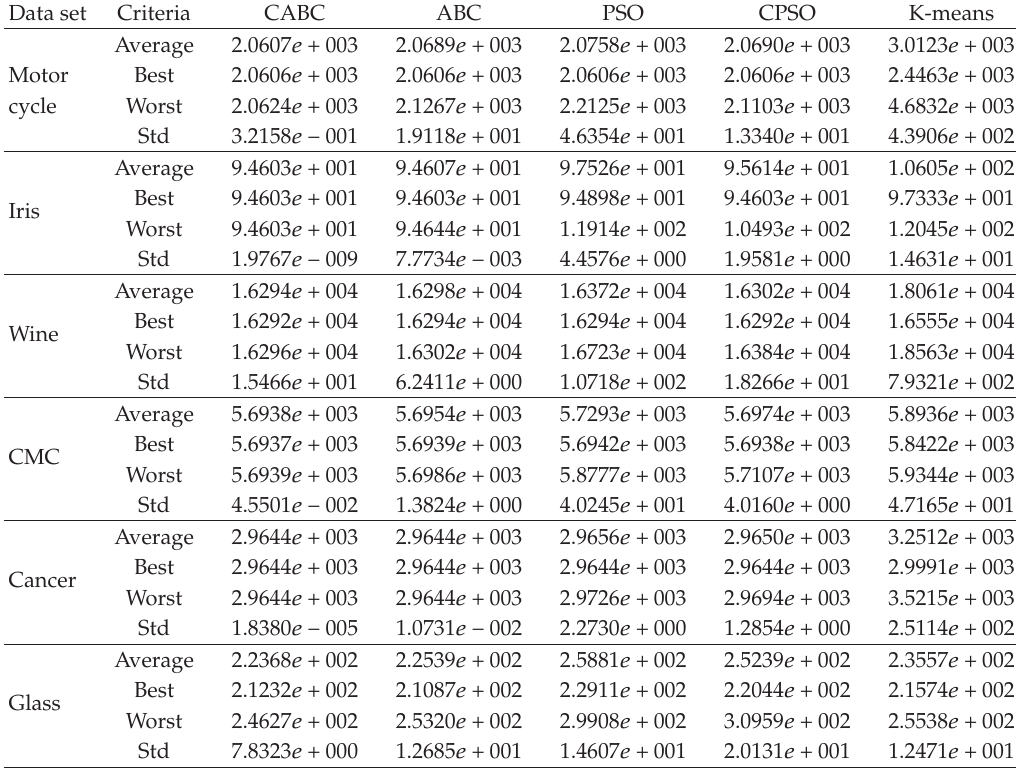
Table 2: Comparison of intracluster distances for the five clustering